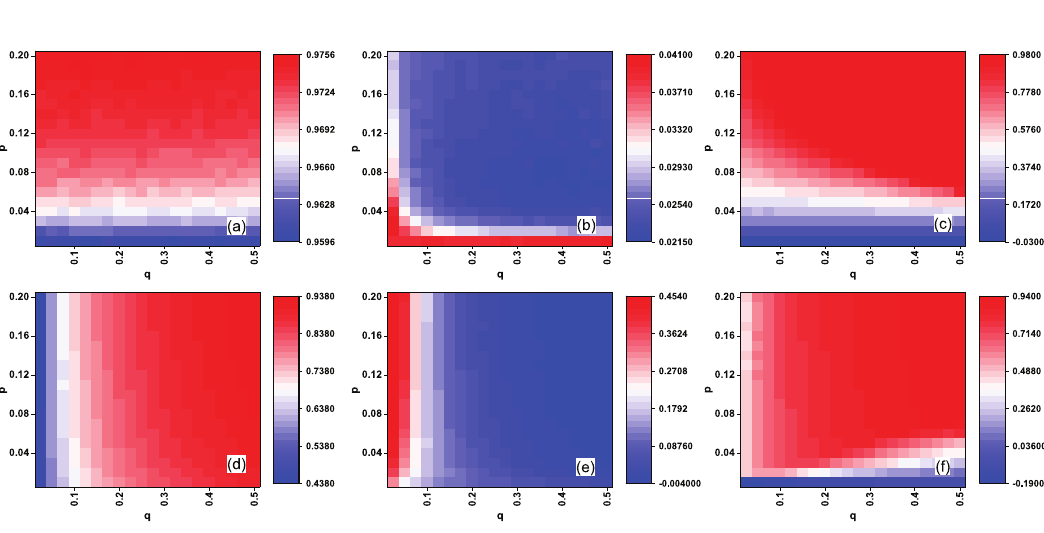
( p , q ) in the malicious rating attack case for the MovieLens data set are shown in Fig 3. The results are similar to those in Fig 2.